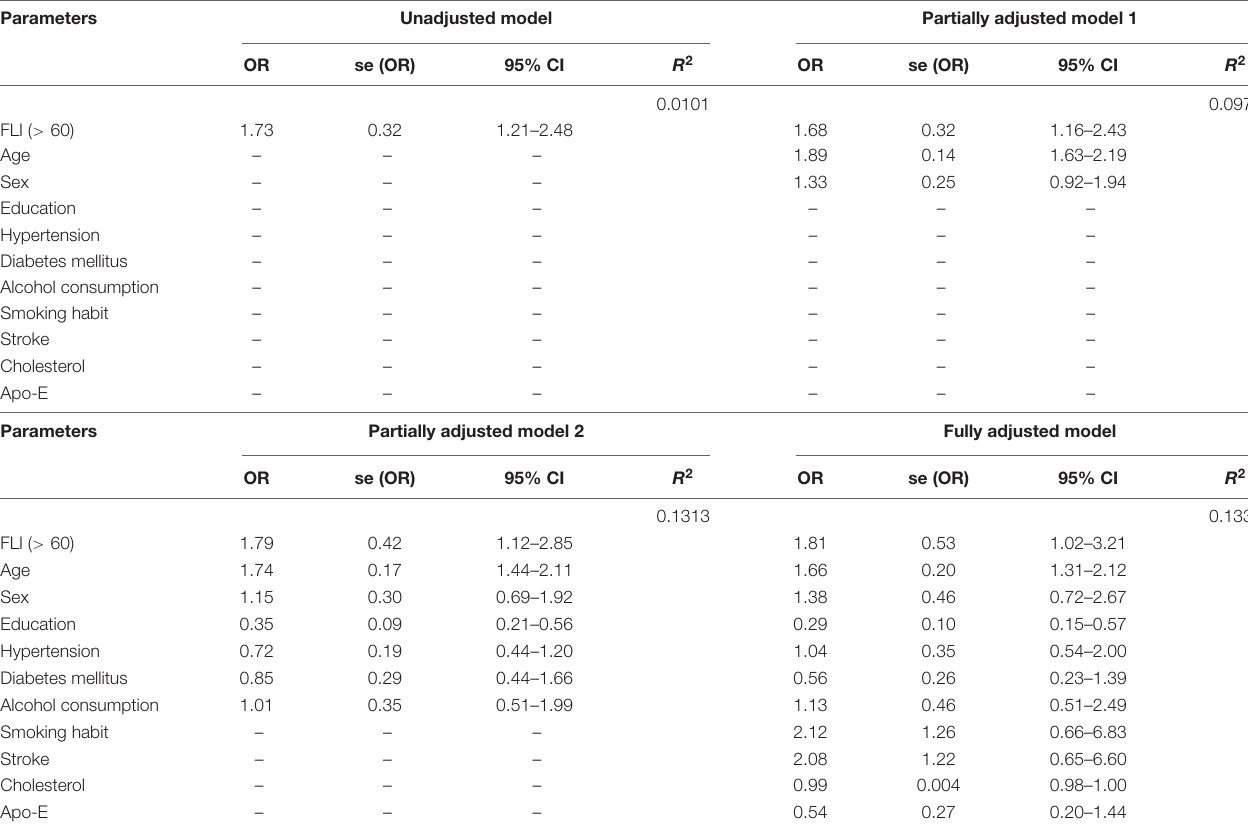
TABLE 2 | Logistic regression multivariable models in cognitively normal subjects and patients with dementia.